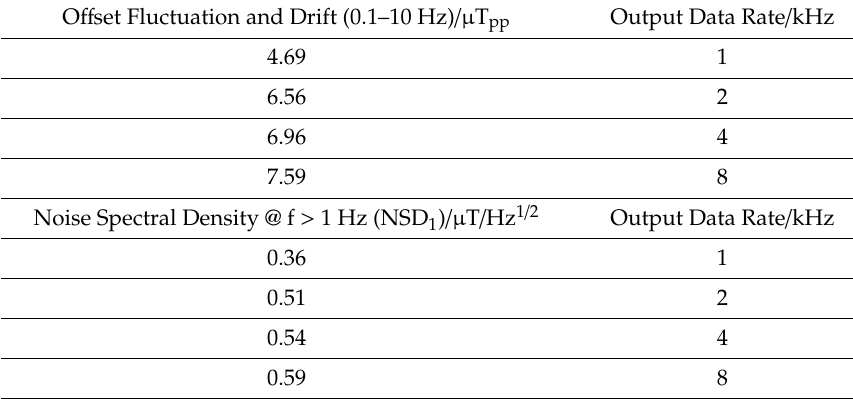
Table 8. Summary of all DC and AC noise